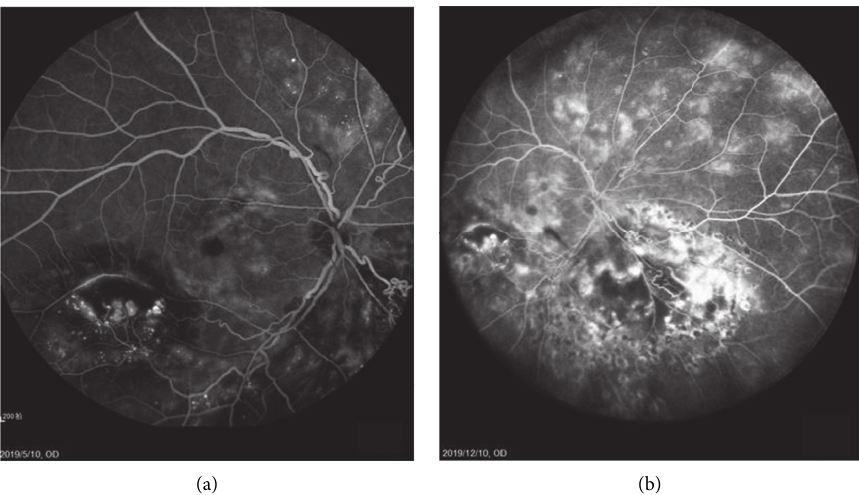
Figure 7: Fluorescein angiographic image of Case 8 in the DEX ( − ) group before and after the laser photocoagulation, intravitreal injection of conbercept (IVC), and transpupillary thermotherapy (TTT). 7A: fluorescein angiographic image showing the retinal telangiectasia, large aneurysmal vascular channels, macular ERD, and periphery capillary nonperfusion at inferior, temporal, and nasal retina before treatment; 7B: fluorescein angiographic image revealed retinal telangiectasia, persist macular ERD, periphery capillary nonperfusion, and leakage at inferior, temporal, and nasal retina after